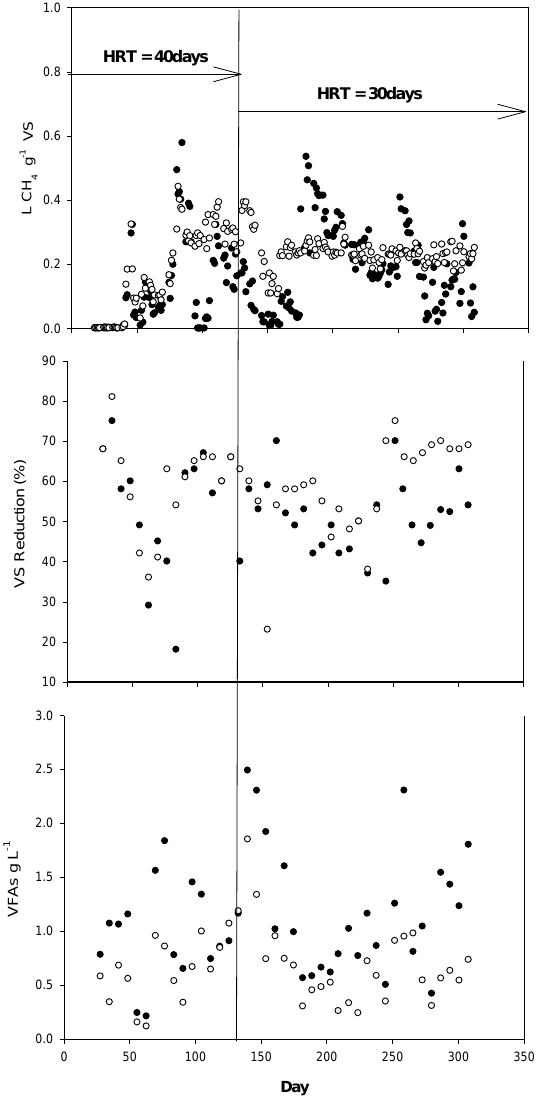
Figure 3. Methane production, volatile solid reduction, and total volatile fatty acids. Blank digester (●), optimised digester ( ○ ).